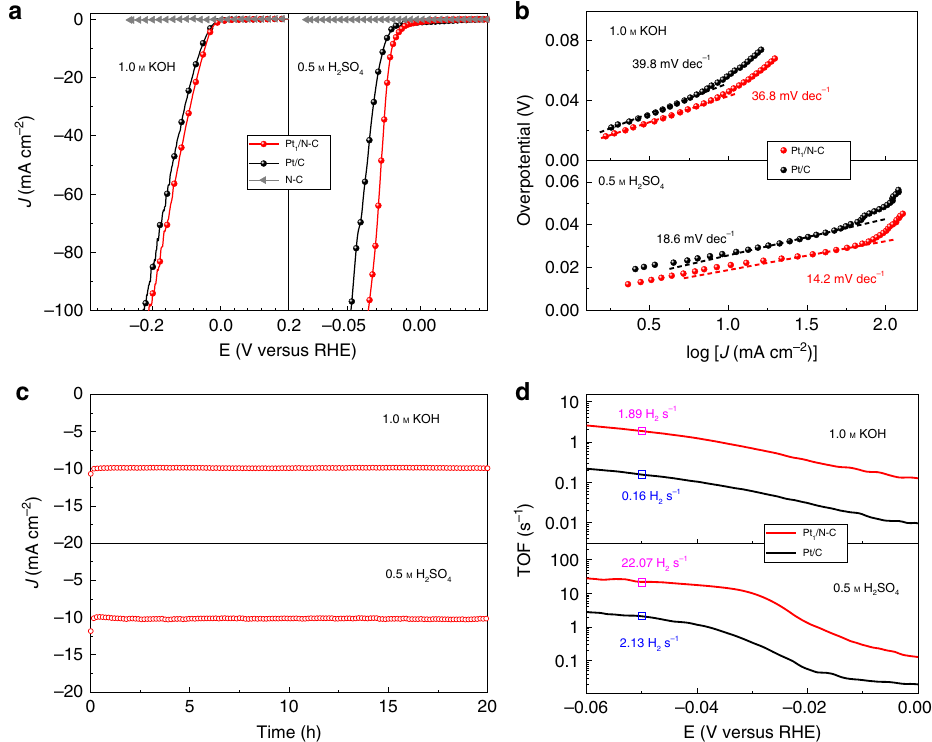
Fig. 4 Electrochemical analysis in both 1.0 M KOH and 0.5 M H 2 SO 4 . a LSV curves of the Pt 1 /N-C, Pt/C and N-C framework. J , current density; E , potential. b Tafel plots for Pt 1 /N-C and Pt/C electrocatalysts. c Durability test of Pt 1 /N-C. d TOF plots of the Pt 1 /N-C and Pt/C